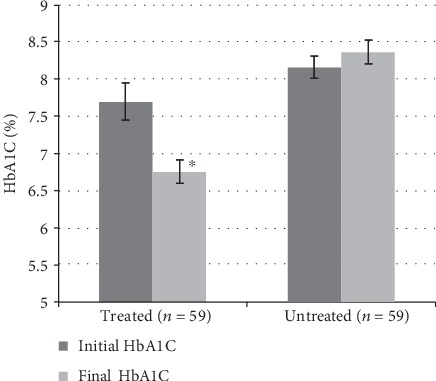
Mean ± SEM initial and final hemoglobin A1C levels (%) in treated patients (n = 59) and untreated patients (n = 59). The difference between the final HbA1C level in treated and untreated patients was significant, as was the difference between the initial and final HbA1C levels in treated patients (∗P < 0.0001).